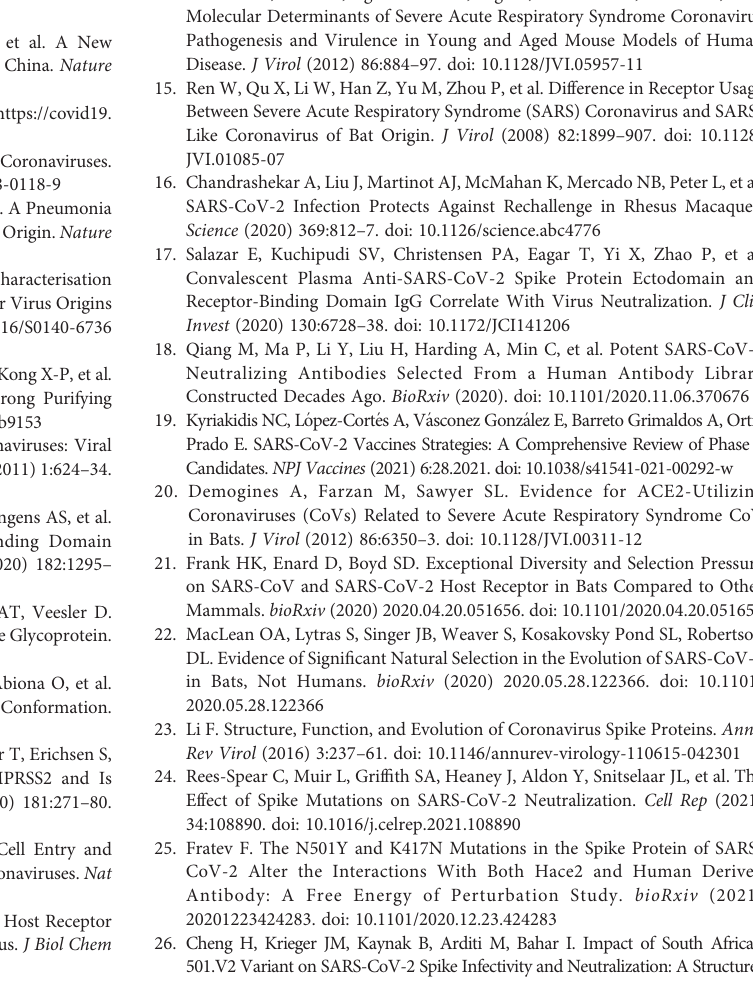
Supplementary Figure 1 | Correlation between binding free energy computed by MM-PBSA and the PRODIGY webserver. Supplementary Figure 2 | Comparison of binding af fi nity computed using the PRODIGY webserver and available experimental data. Binding af fi nities ratios are obtained from the dissociation constant using the formula: RT D ln( K D ) = DD G Exp . (top) Table containing K D , and DD G, DD G Exp and standard error of the mean computed using the RT as reference. (bottom) Correlation between binding af fi nity computed using PRODIGY and DD G Exp .